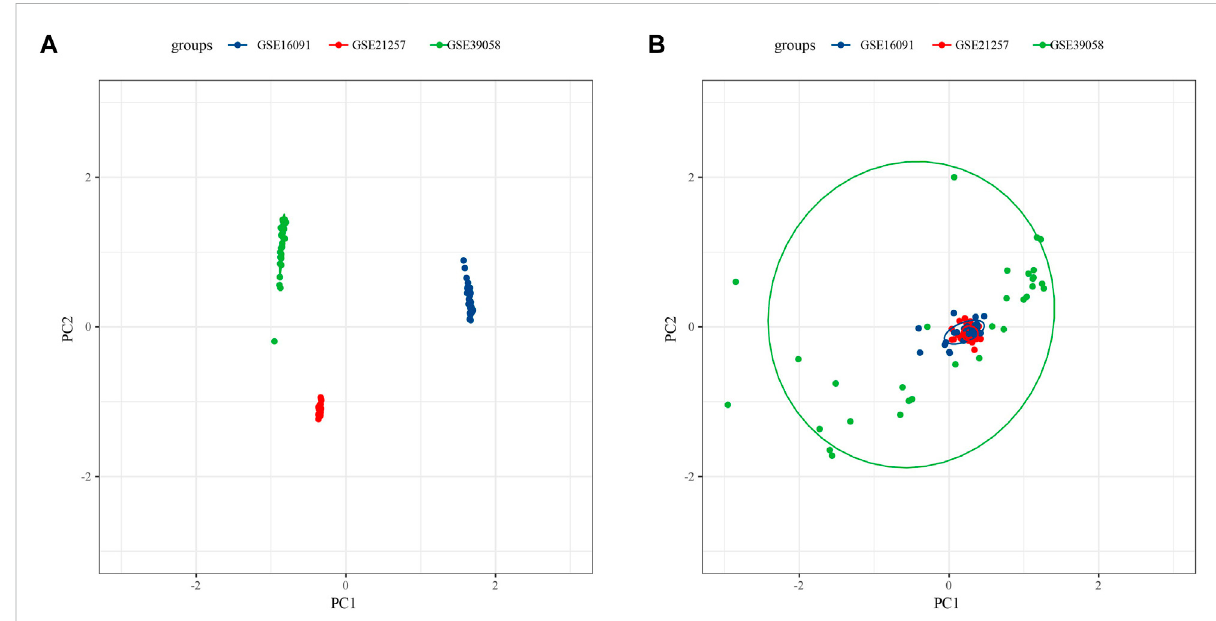
FIGURE 1 Osteosarcoma samples before eliminating the batch effect (A) , the clusters of different databases were clustered more closer than after removal (B)